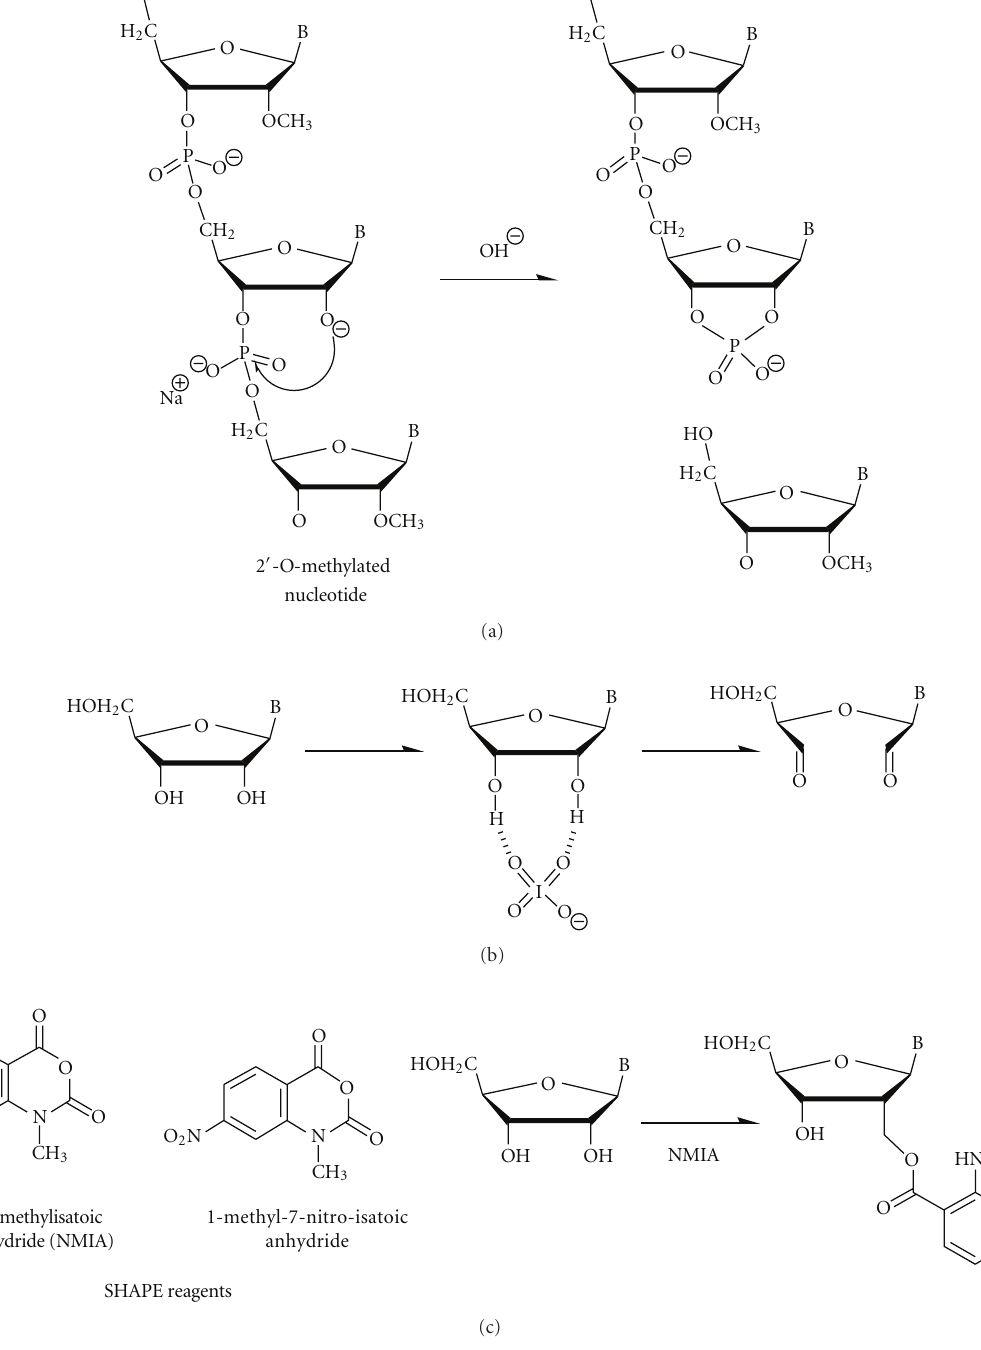
Figure 4: Specific reagents for 2 (cid:2) - O -methylated residues in RNA. (a) Selective cleavage of nonmethylated ribose residues at alkaline pH. The 2 (cid:2) - O -methylated residues are resistant for such cleavage. (b) Periodate oxydation of cisdiol residues at the terminal 3 (cid:2) -ribose. (c) Acylation of ribose free 2 (cid:2) -OH by SHAPE reagents N-methylisatoic anhydride (NMIA) and 1-methyl-7-nitro-isatoic anhydride.